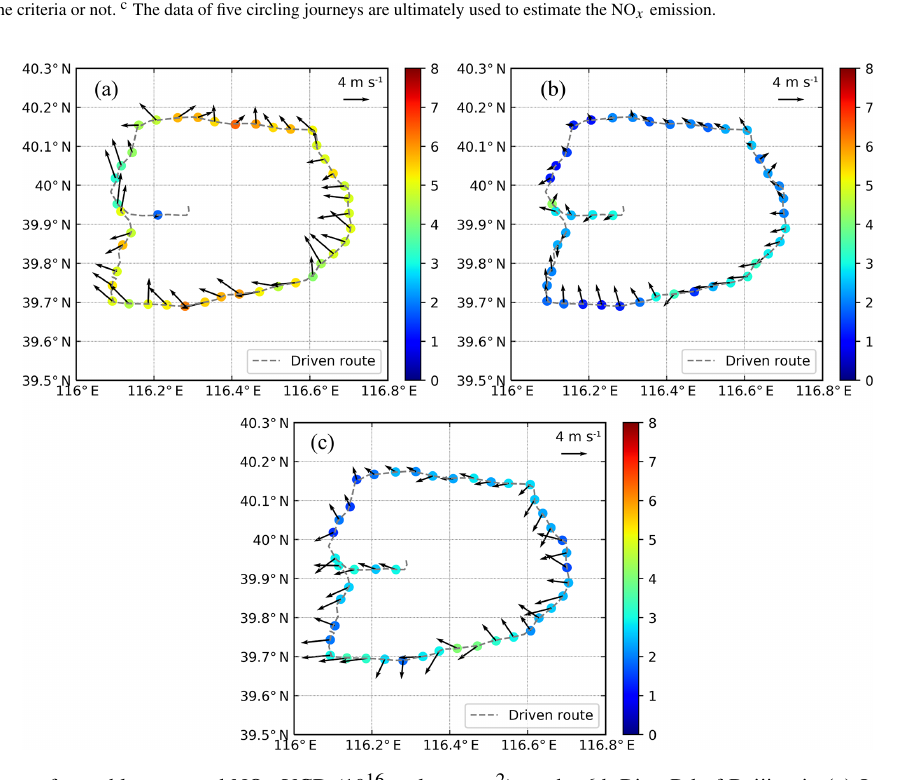
Figure 5. Distributions of monthly averaged NO 2 VCD (10 16 molec.cm − 2 ) on the 6th Ring Rd of Beijing in (a) January, (b) September, and (c) October